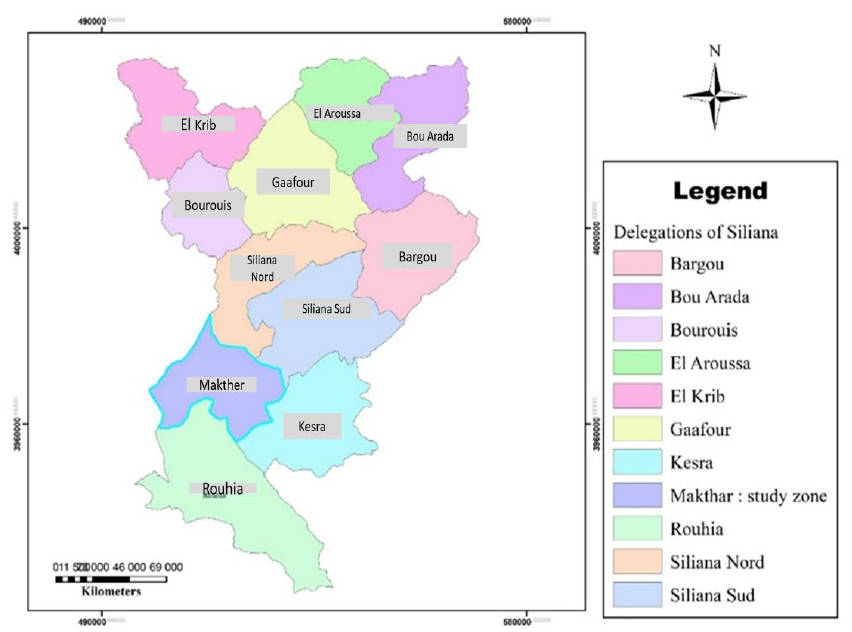
Figure 1. Location of the study area.